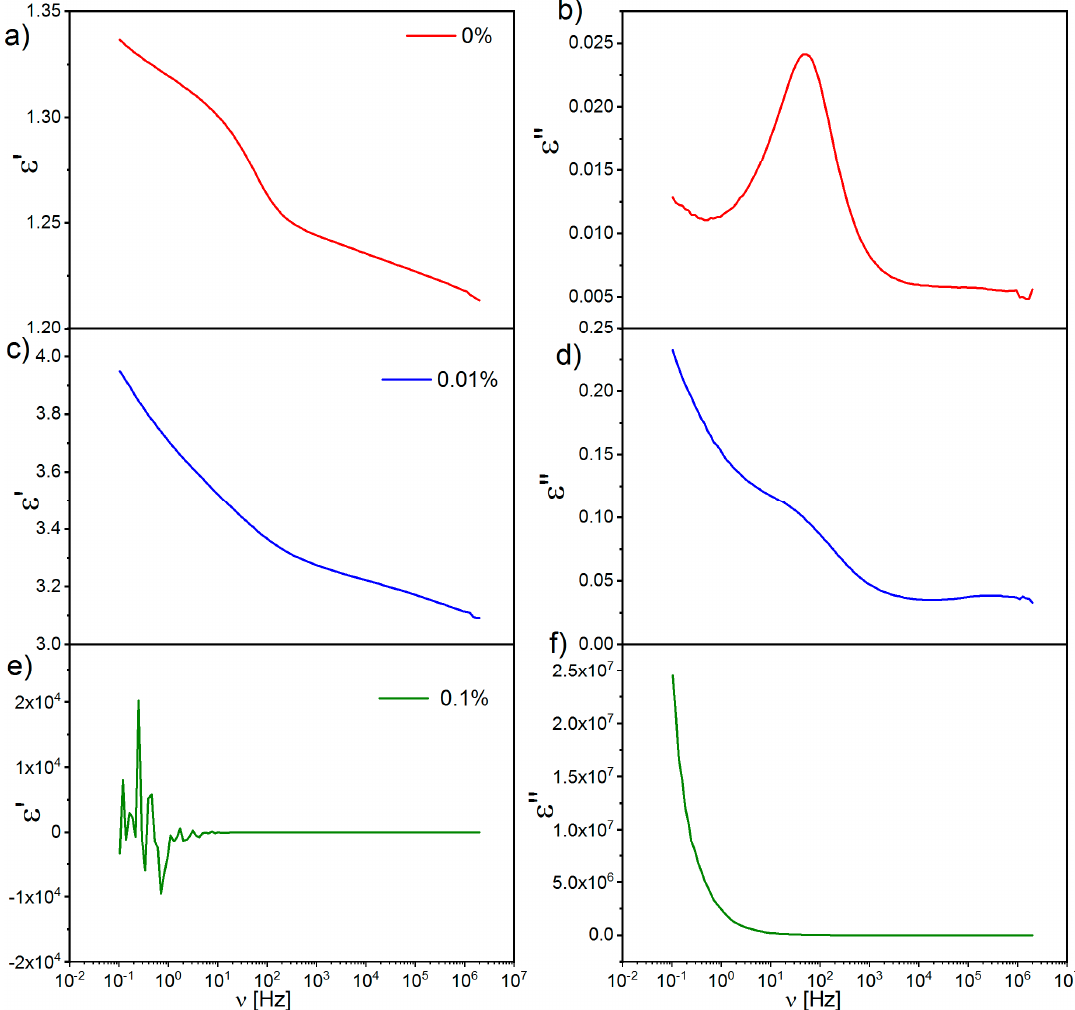
Figure 7. Dielectric dispersion ( a ) and absorption ( b ) registered for pure L , D -PLA, dielectric dispersion ( c ) and absorption ( d ) registered for mixture with SWCN content of 0.01%, dielectric dispersion ( e ) and absorption ( f ) registered for mixture with SWCN content of 0.1%; room temperature.